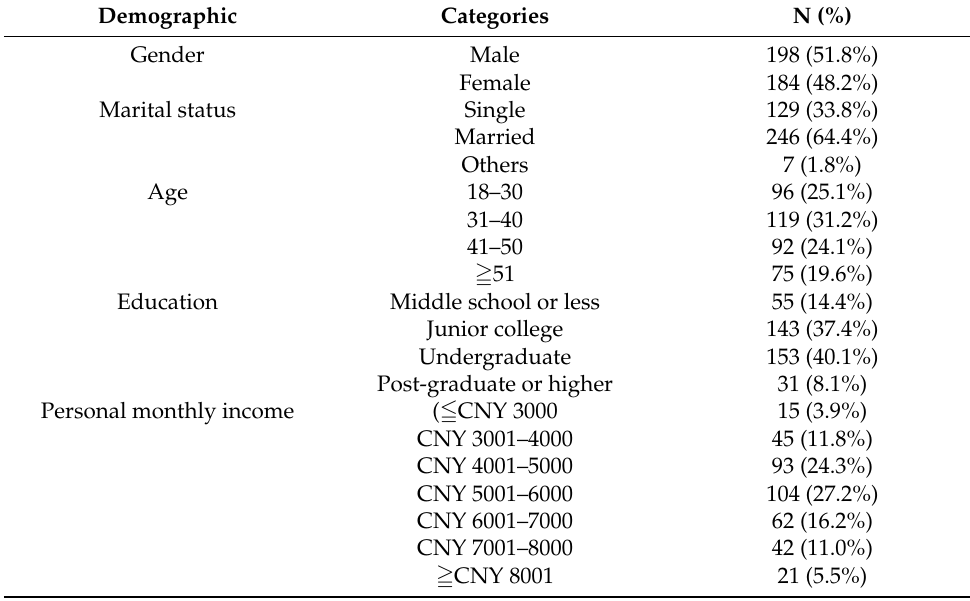
Table 2. Results of measurement model.